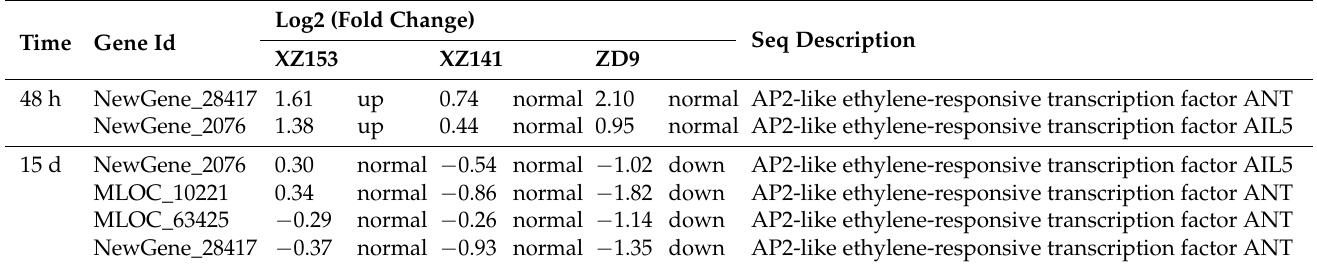
Table 3. Summary of AP2-like ethylene-responsive transcription factors participated in ethylene biosynthesis.